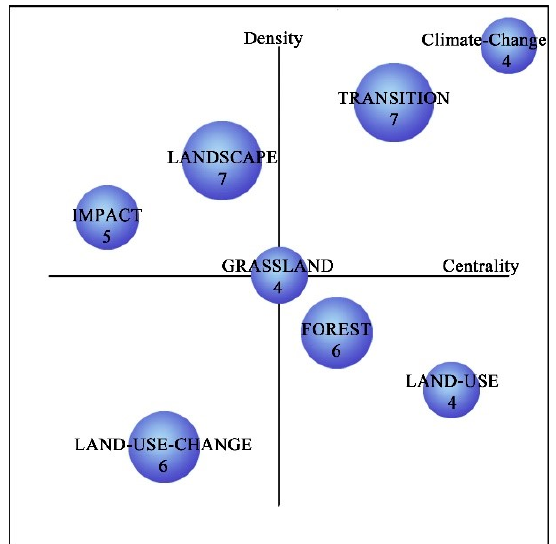
Figure 9. Farmland abandonment strategic diagram (2017–2019).